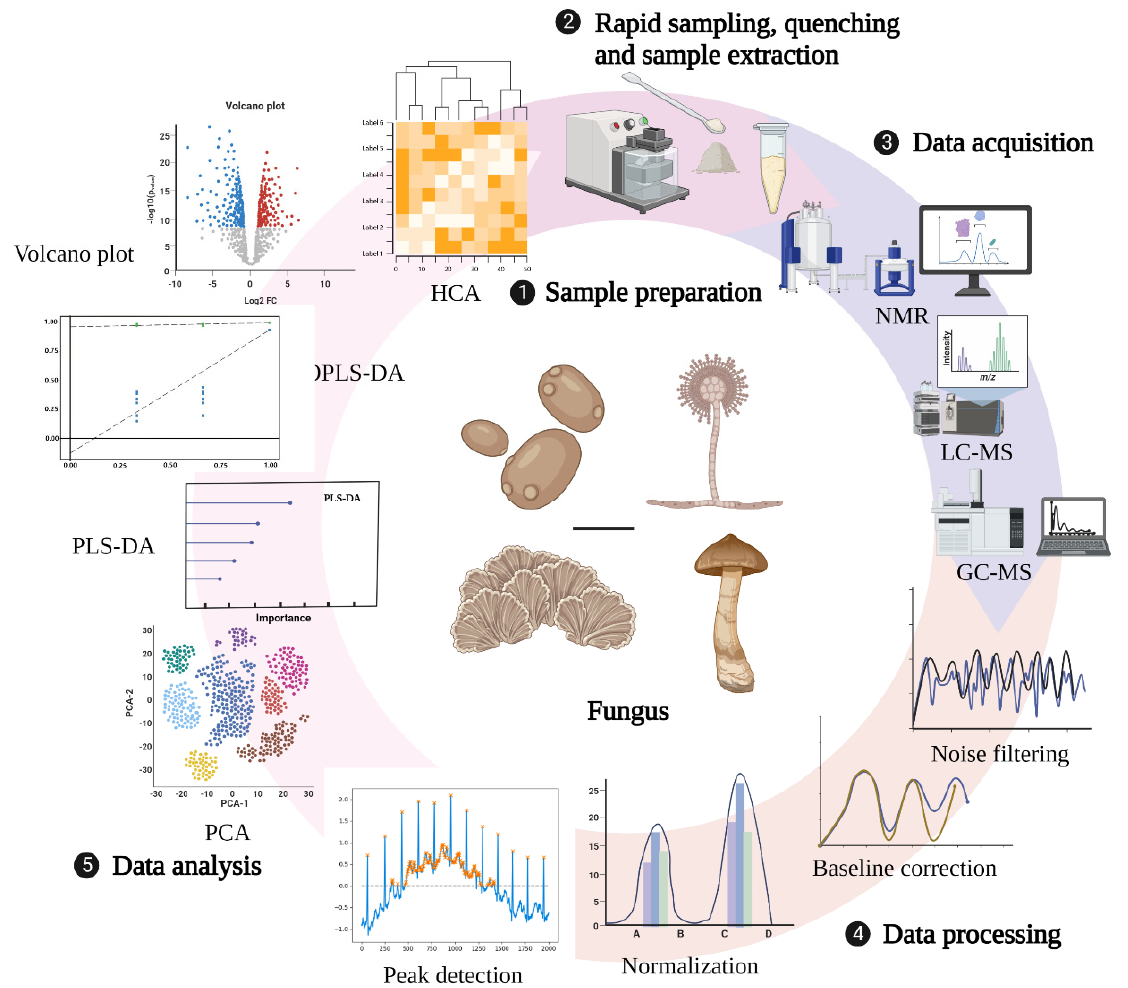
Figure 1. General technical route of metabolomics. Created with BioRender.com. (Accessed on 28 October 2022)